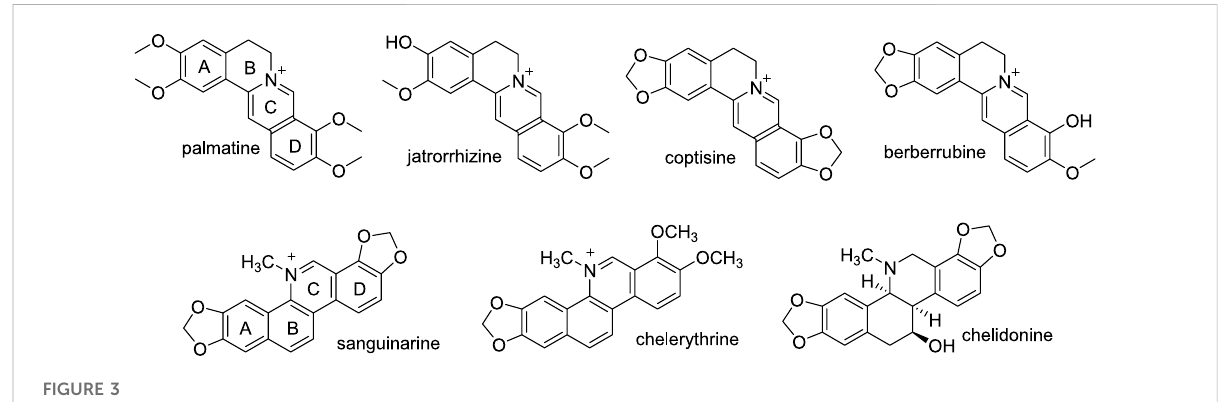
FIGURE 3 The structures of representatives of PBs, and benzo[c]